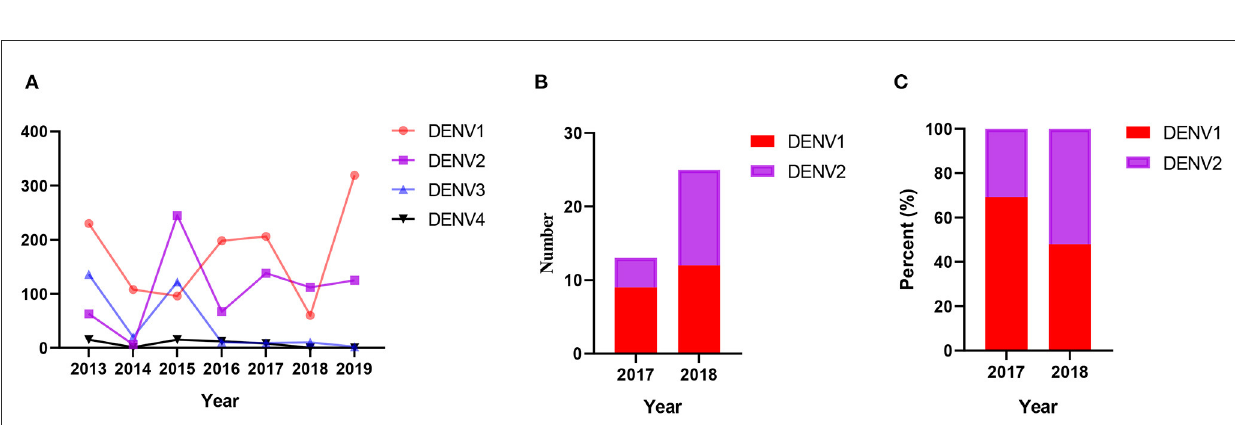
FIGURE2 (A) The number of DENV1-4 strains in the GenBank datasets from 2013 to 2019 in Yunnan, China. (B) The number of different DENV strains in this study. (C) The percentage of different DENV strains in this study.